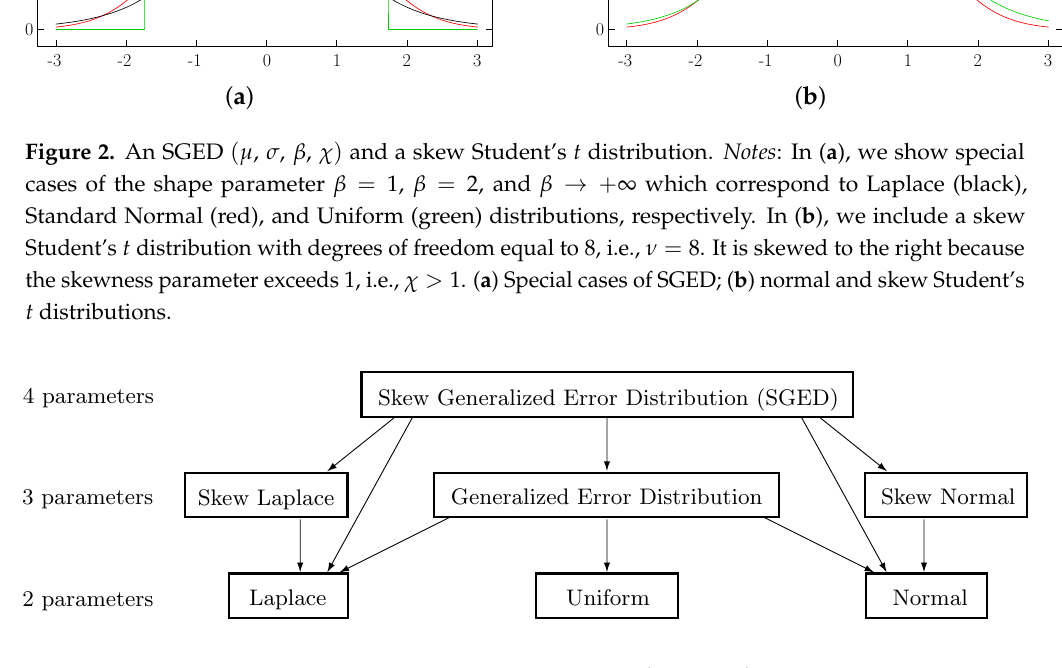
Figure 3. All special cases of SGED ( µ , σ , β , χ )